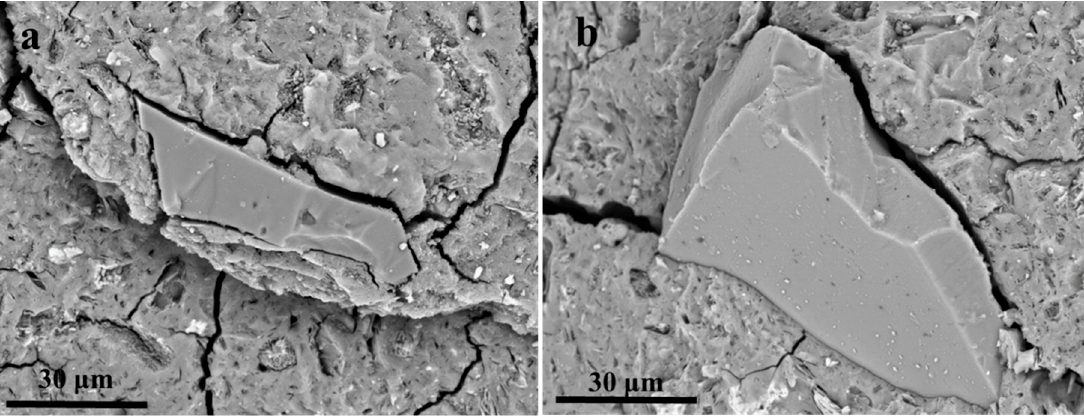
Figure 10. SEM images of the fracture surface of MK-based geopolymers synthesized with ( a ) quartz-1 and ( b ) AQ1-5.